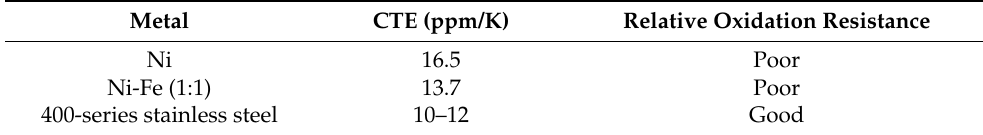
Table 1. The comparison between Ni, Ni-Fe, and 400-series stainless steels [5]. Metal CTE